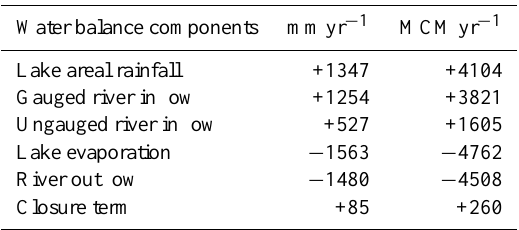
Table 7. Lake Tana water balance components simulated for the period